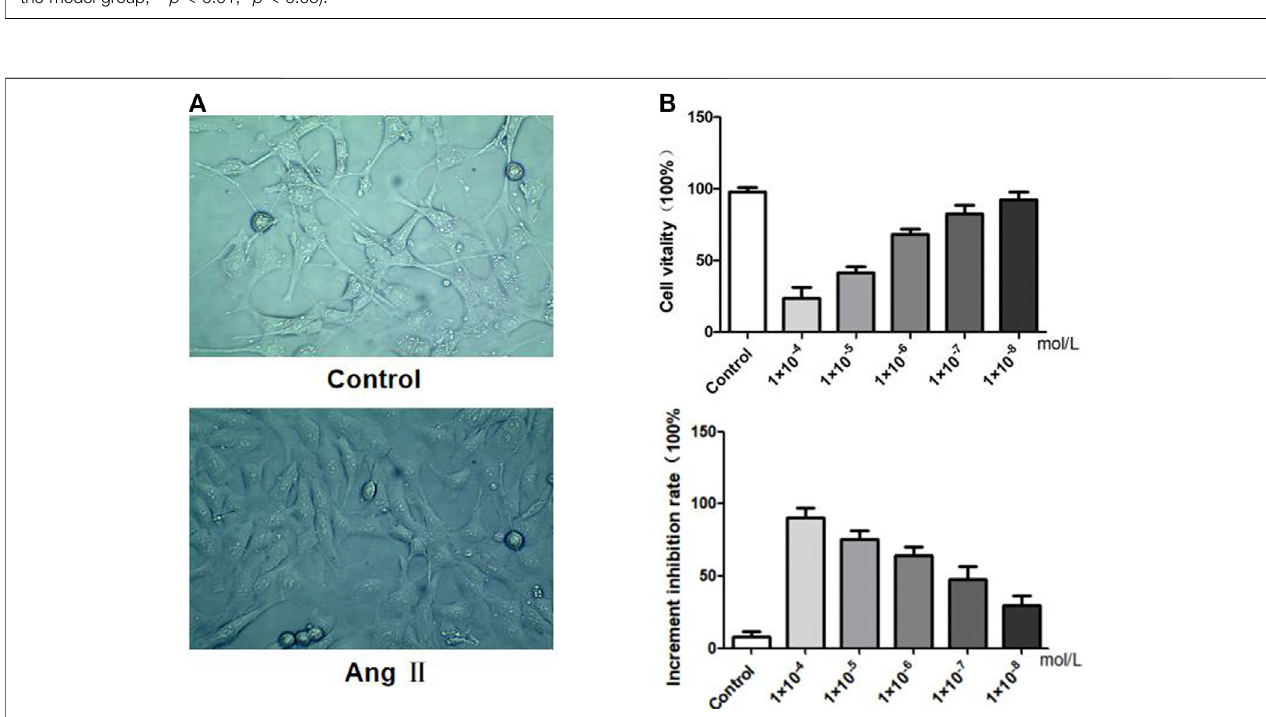
FIGURE 5 | Effects of Ang Ⅱ on MPC5 podocyte stimulation. (A) Morphological observation of podocytes before and after Ang Ⅱ intervention. (B) Effects of Ang Ⅱ concentration on podocyte viability and proliferation inhibitory rate.